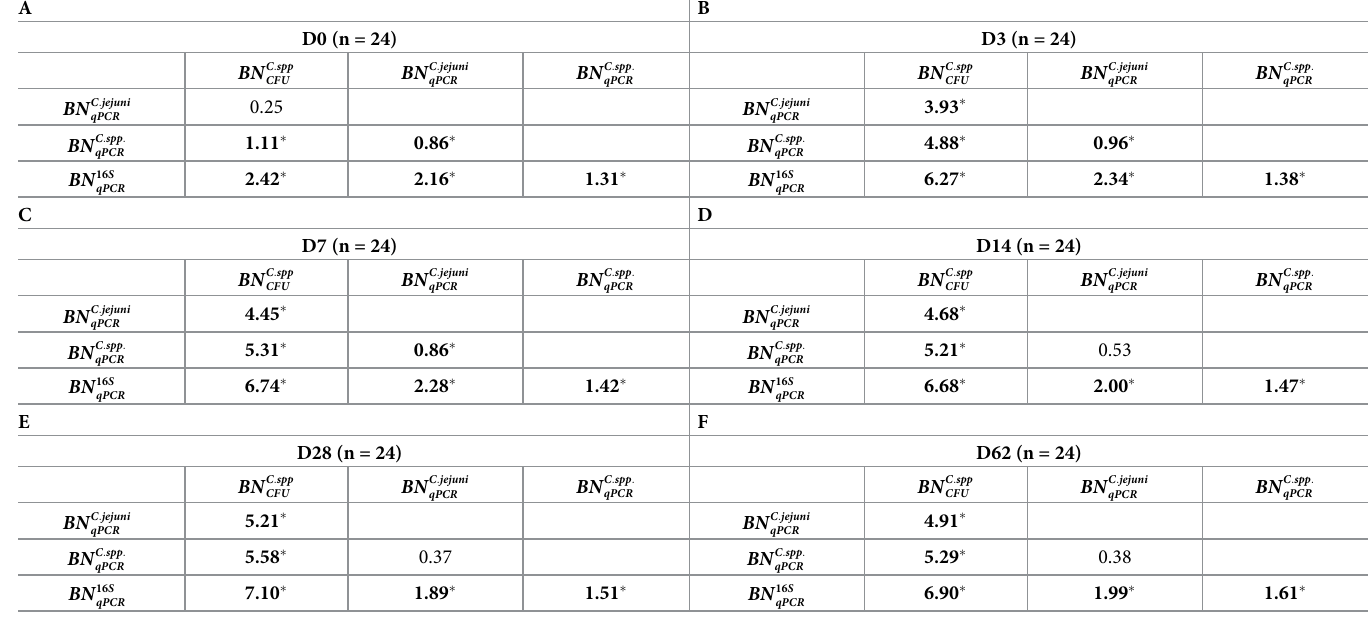
Table 4. Log 10 bacteria concentration amongst different analyses throughout the six experimental time points (i.e., columns -rows and letters from A to F) Statisti- cally, significant differences (Tukey HSD) are indicated in bold and with the symbol �